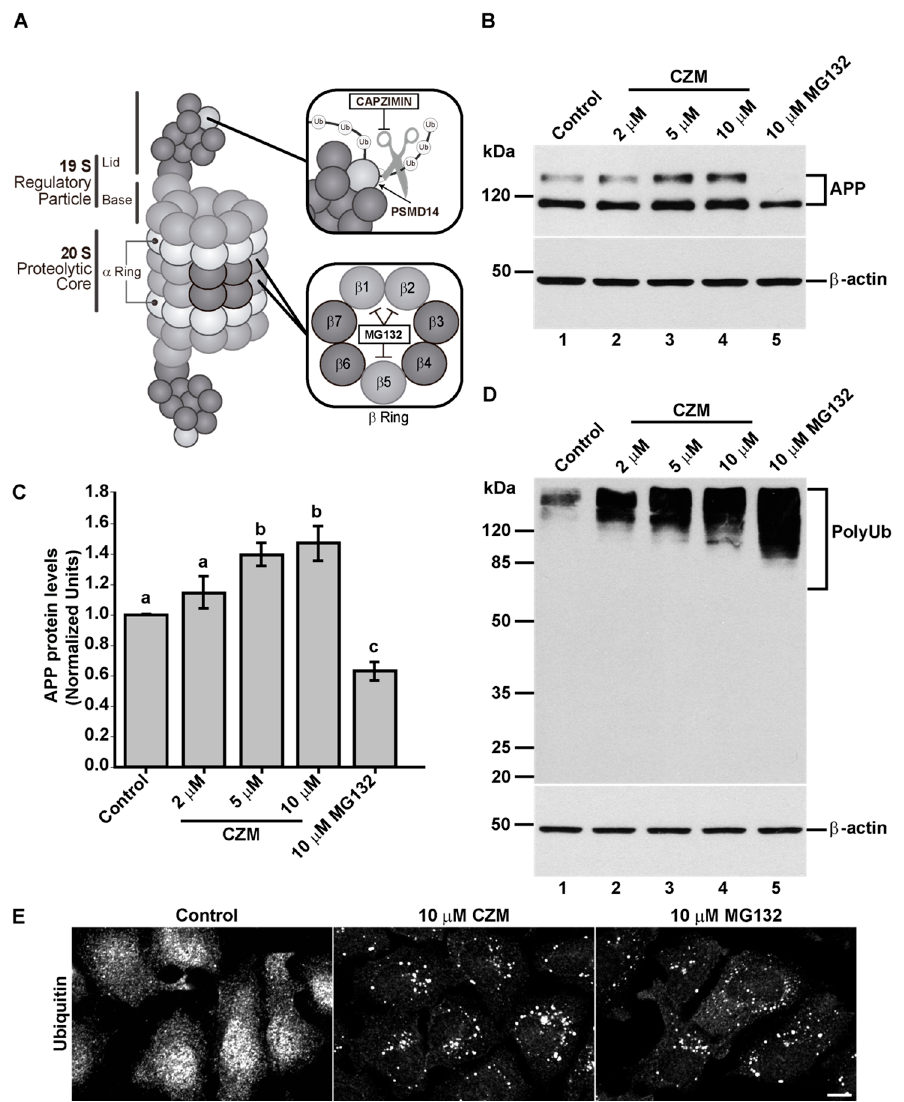
Figure 3. Acute inhibition of PSMD14 by Capzimin CZM shows a similar phenotype as that of PSMD14 KD on the levels of APP and high molecular weight Ub conjugates. ( A ) Schematic diagram of the molecular targets of Capzimin and MG132 in the 19S RP and 20S catalytic core of the proteasome, respectively. ( B ) Parental H4 cells were treated either with vehicle (DMSO; Control), or increasing doses of CZM for 4 h, or MG132 for 6 h. Protein extracts were analyzed by western blot with a polyclonal antibody to endogenous APP. Monoclonal antibody to β -actin (clone BA3R) was used as a loading control. The position of molecular mass markers is indicated on the left. ( C ) Densitometric quantification of APP protein levels as shown in ( D ). Statistical significance was determined by one-way ANOVA, followed by Tukey’s test. Bars represent the mean ± SD of biological replicates ( n = 4). Different letters above the mean bars apply to significant differences between groups p < 0.05. ( D ) Parental H4 cells were treated as in ( B ), and the protein extracts were analyzed by western blot with a polyclonal antibody to Ub that recognizes all types of Ub conjugate. Monoclonal antibody to β -actin (clone BA3R) was used as a loading control. The position of molecular mass markers is indicated on the left. ( E ) Immunofluorescence microscopy images of the cellular localization of Ub in parental H4 cells treated with either the vehicle (DMSO; Control), CZM for 4 h or MG132 for 6 h. Cells were fixed, permeabilized and stained with a mouse monoclonal antibody to Ub (clone P4D1) followed by Alexa-488-conjugated donkey anti-mouse IgG. Scale bar, 10 µ m. ( n = 3). To unveil this possibility, immunofluorescence analysis of endogenous APP in parental H4 cells was performed. We observed that the treatment with 10 µM CZM resulted in a perinuclear